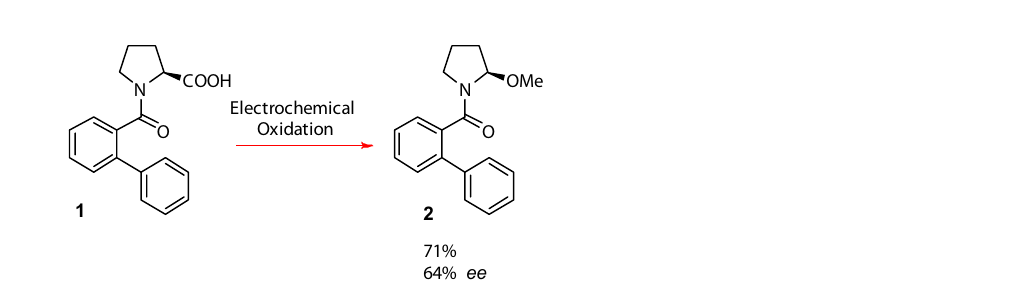
Figure 2. Electrochemical oxidation of an N-benzoylated serine derivative.